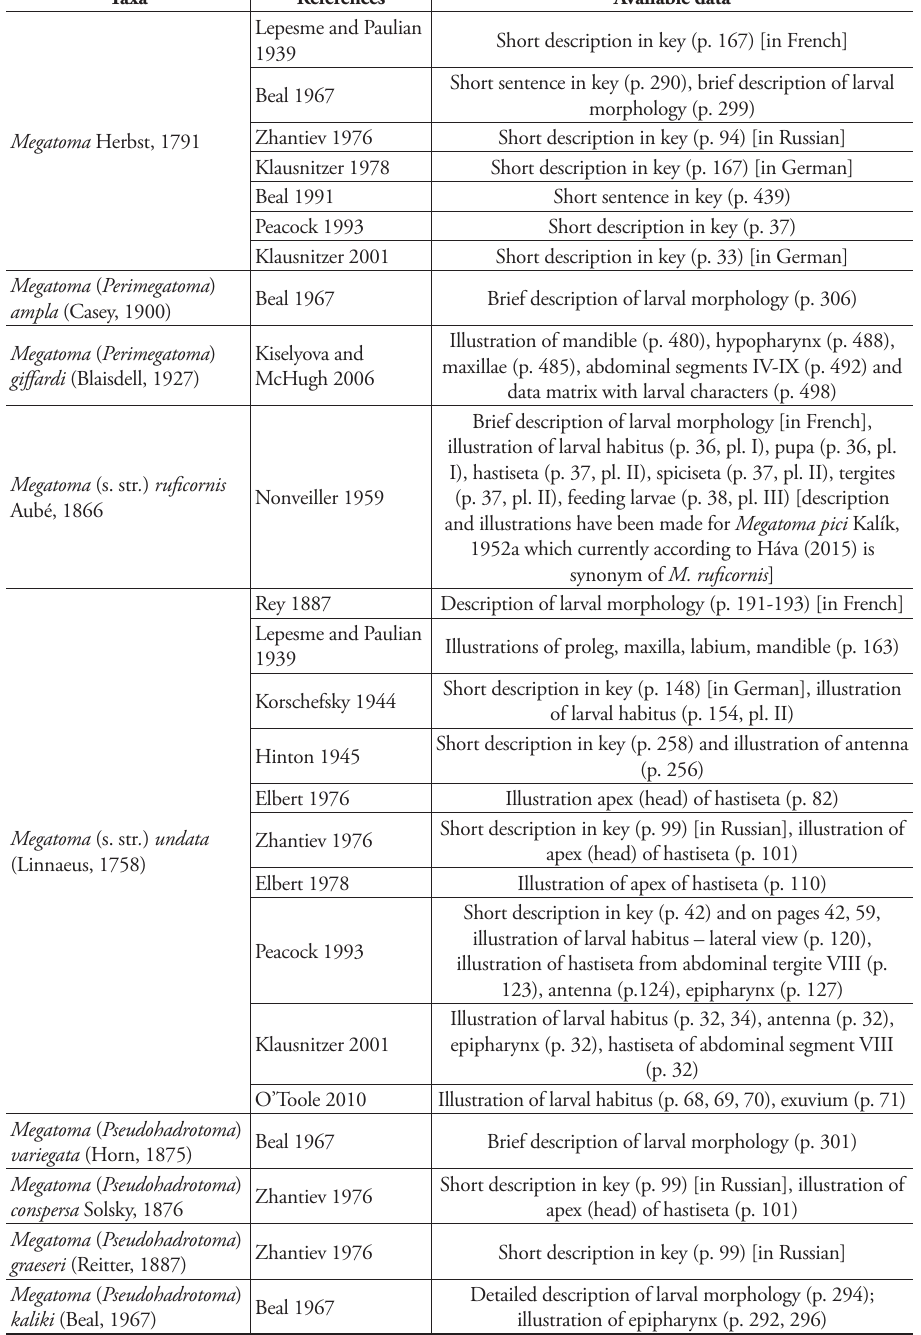
Table 1. List of Megatoma species with references related to larval morphological